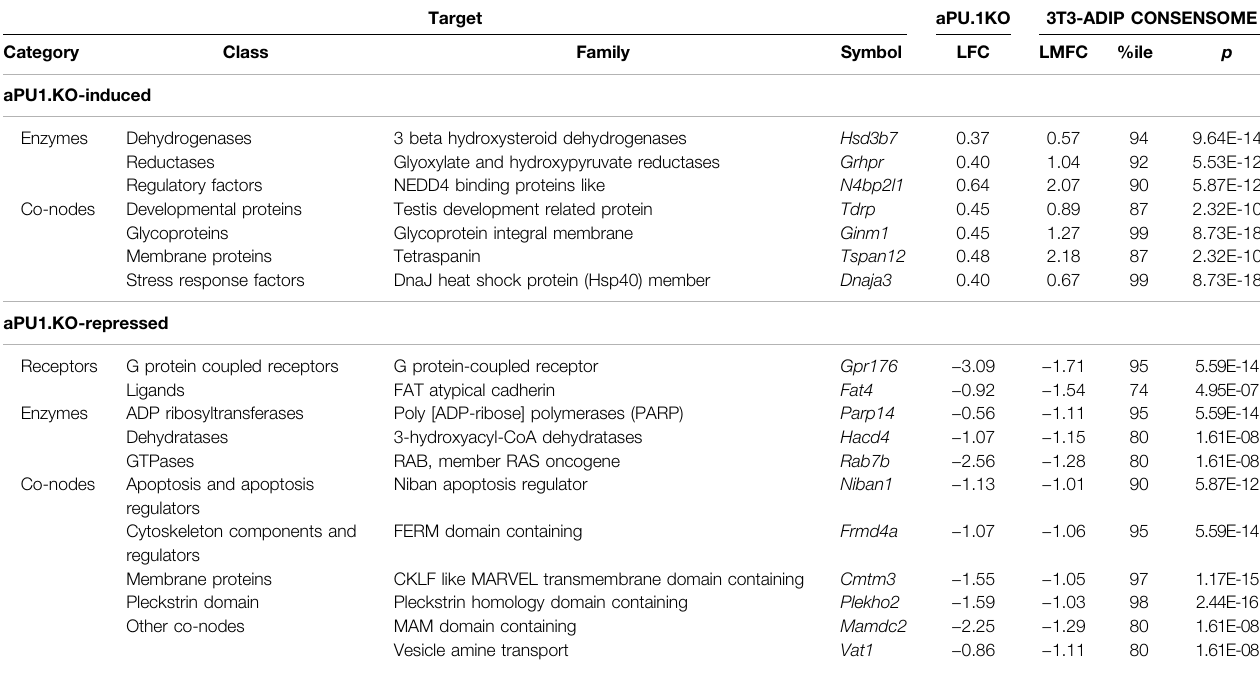
TABLE 1 | Selected PU.1 regulated genes with elevated rankings in the 3T3-L1 adipogenesis transcriptomic consensome. Target